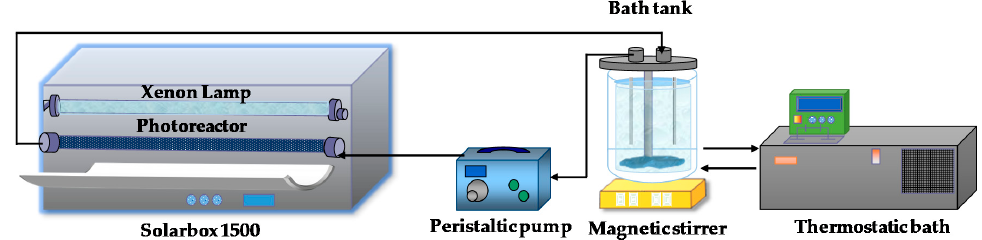
Figure 12. Solar simulator